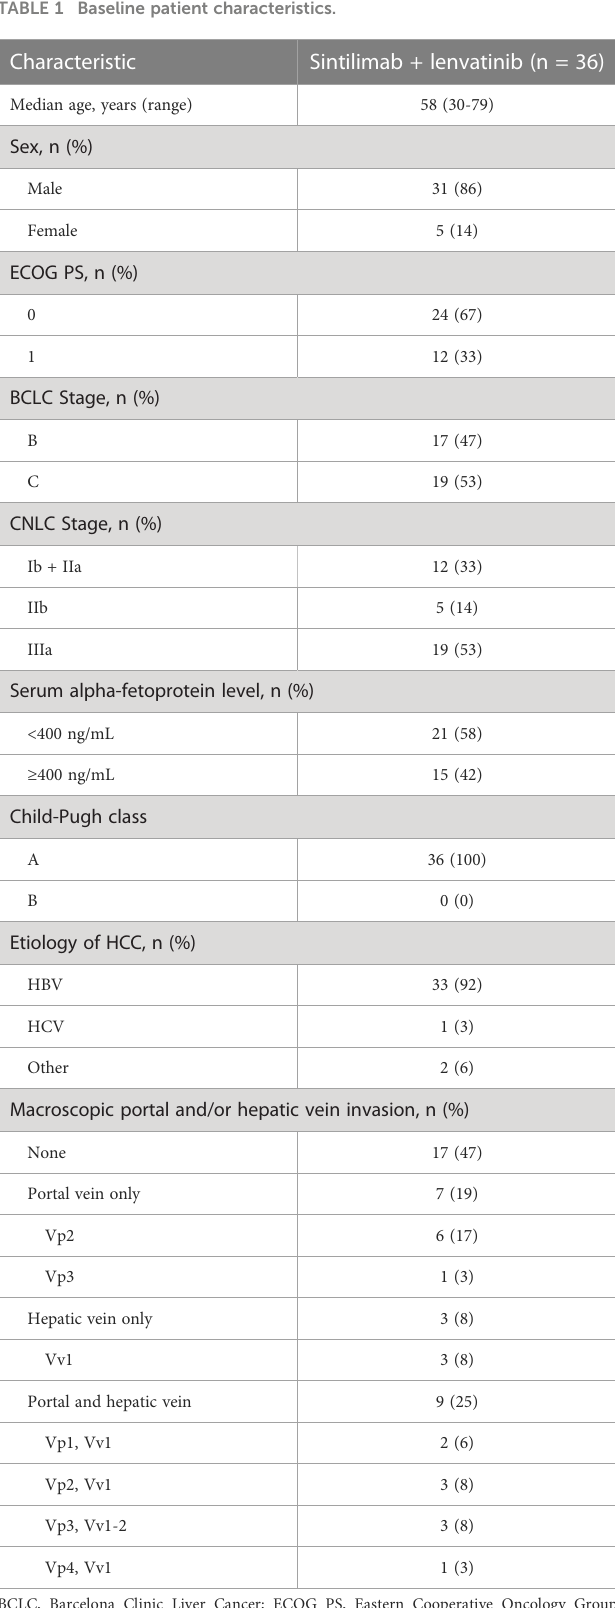
TABLE 1 Baseline patient characteristics.